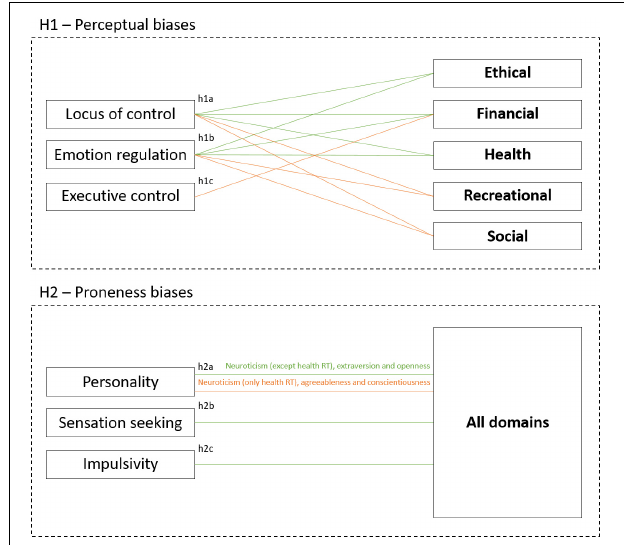
FIGURE 1 | Study hypotheses. Red lines represent positive relation and orange lines represent negative